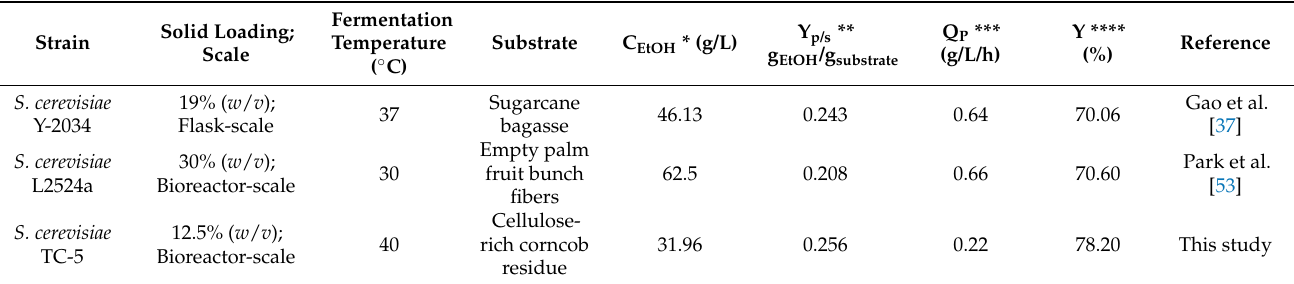
Table 3. Comparison of bioethanol production from S. cerevisiae using lignocellulosic biomass via fed-batch simultaneous saccharification and fermentation (fed-batch SSF).